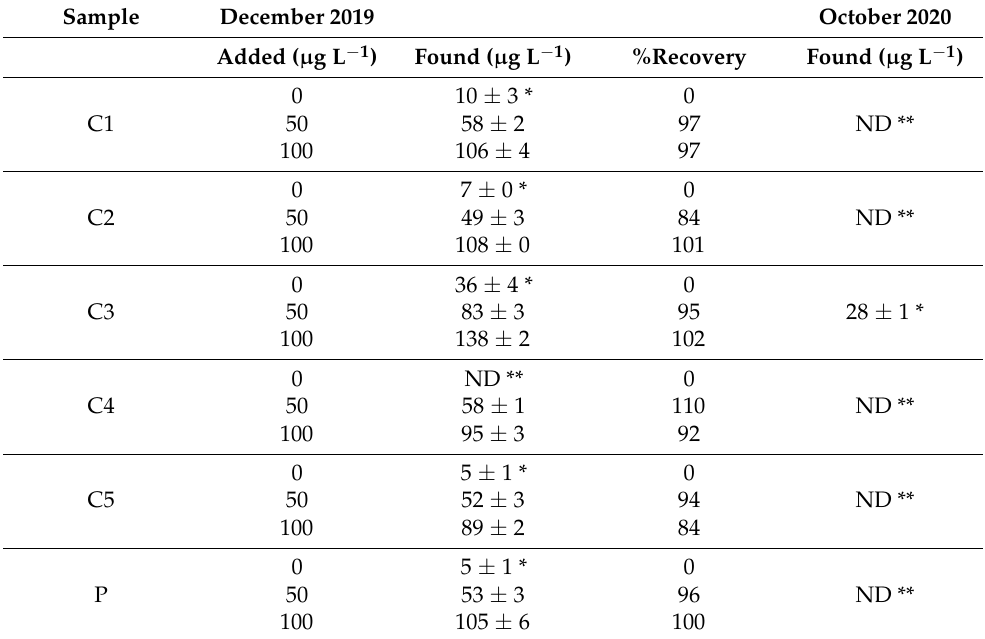
Table 2. Real sample